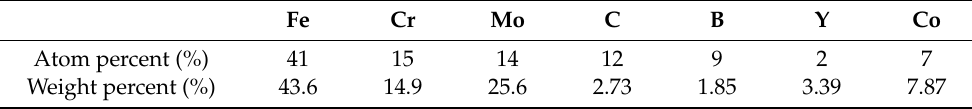
Table 1. Compositions of the iron-based metallic glass.